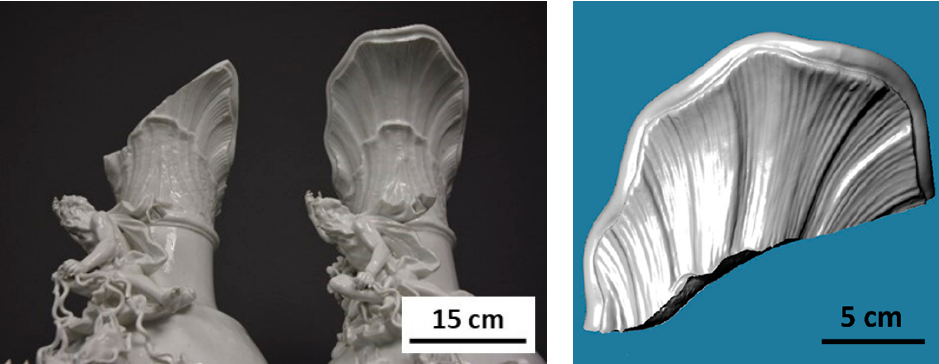
Figure 1. Left : Splendid vases made by Johann Joachim Kändler in the 18th century (courtesy: Staat- Figure 1. ( Left ): Splendid vases made by Johann Joachim Kändler in the 18th century (courtesy: liche Porzellansammlung Dresden, Germany); right : 3D-reconstruction of the missing fragment Staatliche Porzellansammlung Dresden, Germany); ( right ): 3D-reconstruction of the missing fragment with fracture surface (courtesy: Cox3D Pirna, Germany). with fracture surface (courtesy: Cox3D Pirna,